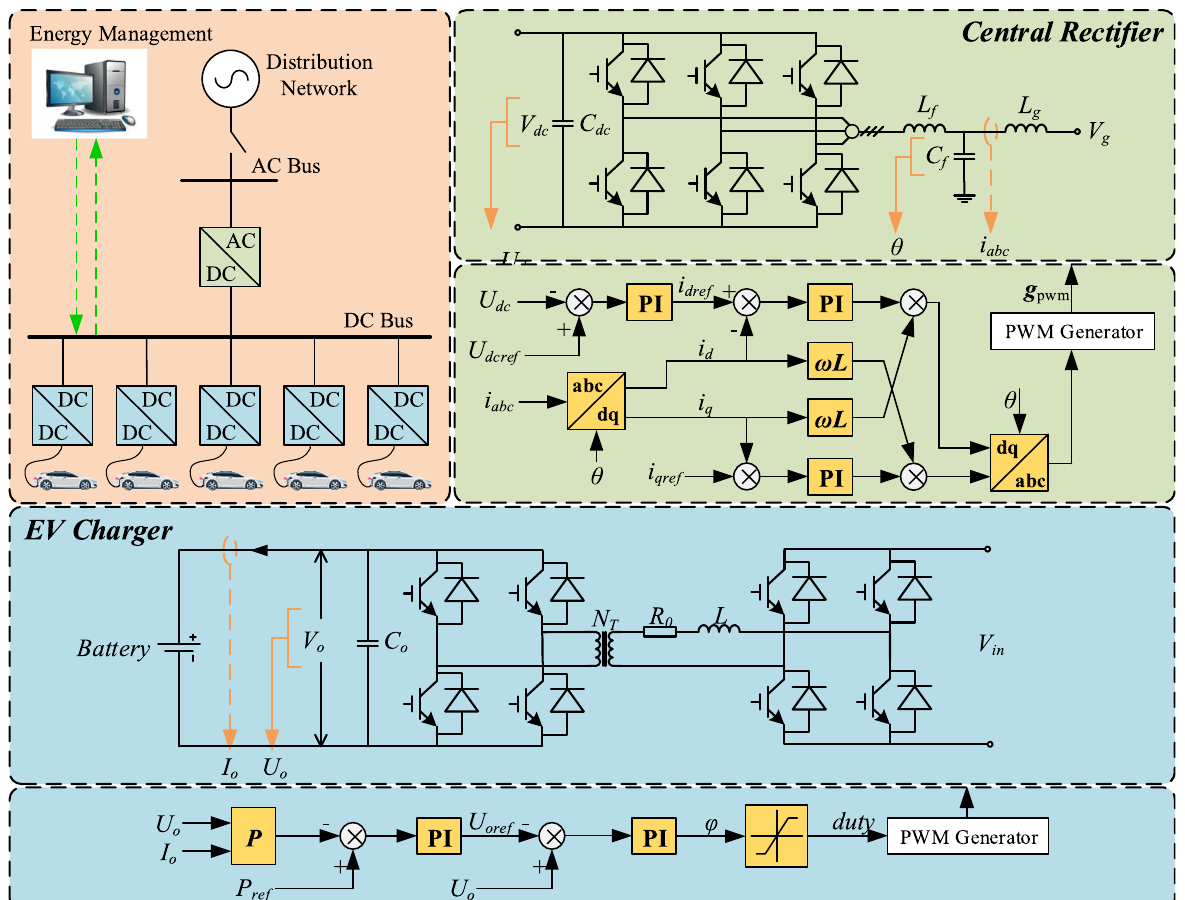
Fig. 1 EV charging system